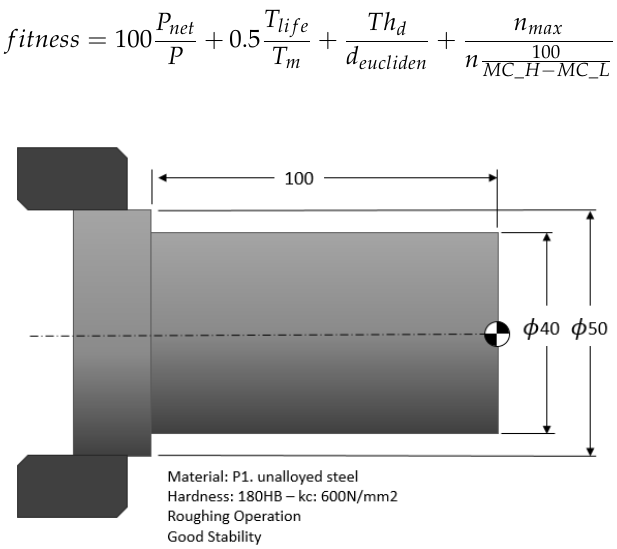
Figure 8. Example of a light roughing operation. Table 9. Working specifications of the light roughing operation example.